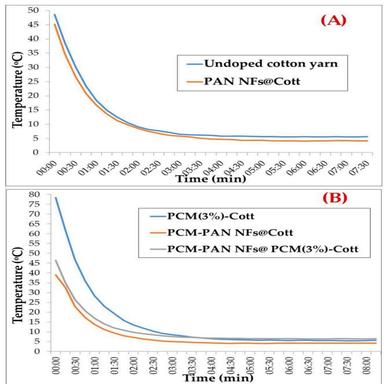
T-History results of undoped cotton and PCM-PAN NFs@ Cott (A), and various PCM nanocapsule-doped composite yarns (for 3 % PCM concentration) (B).